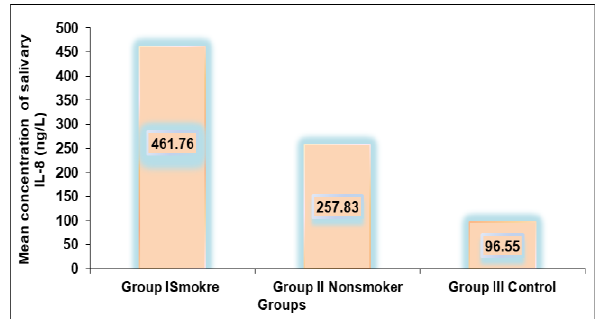
Figure 1: Mean levels of IL-8 in saliva of smoker and non-smoker periodontitis groups and control